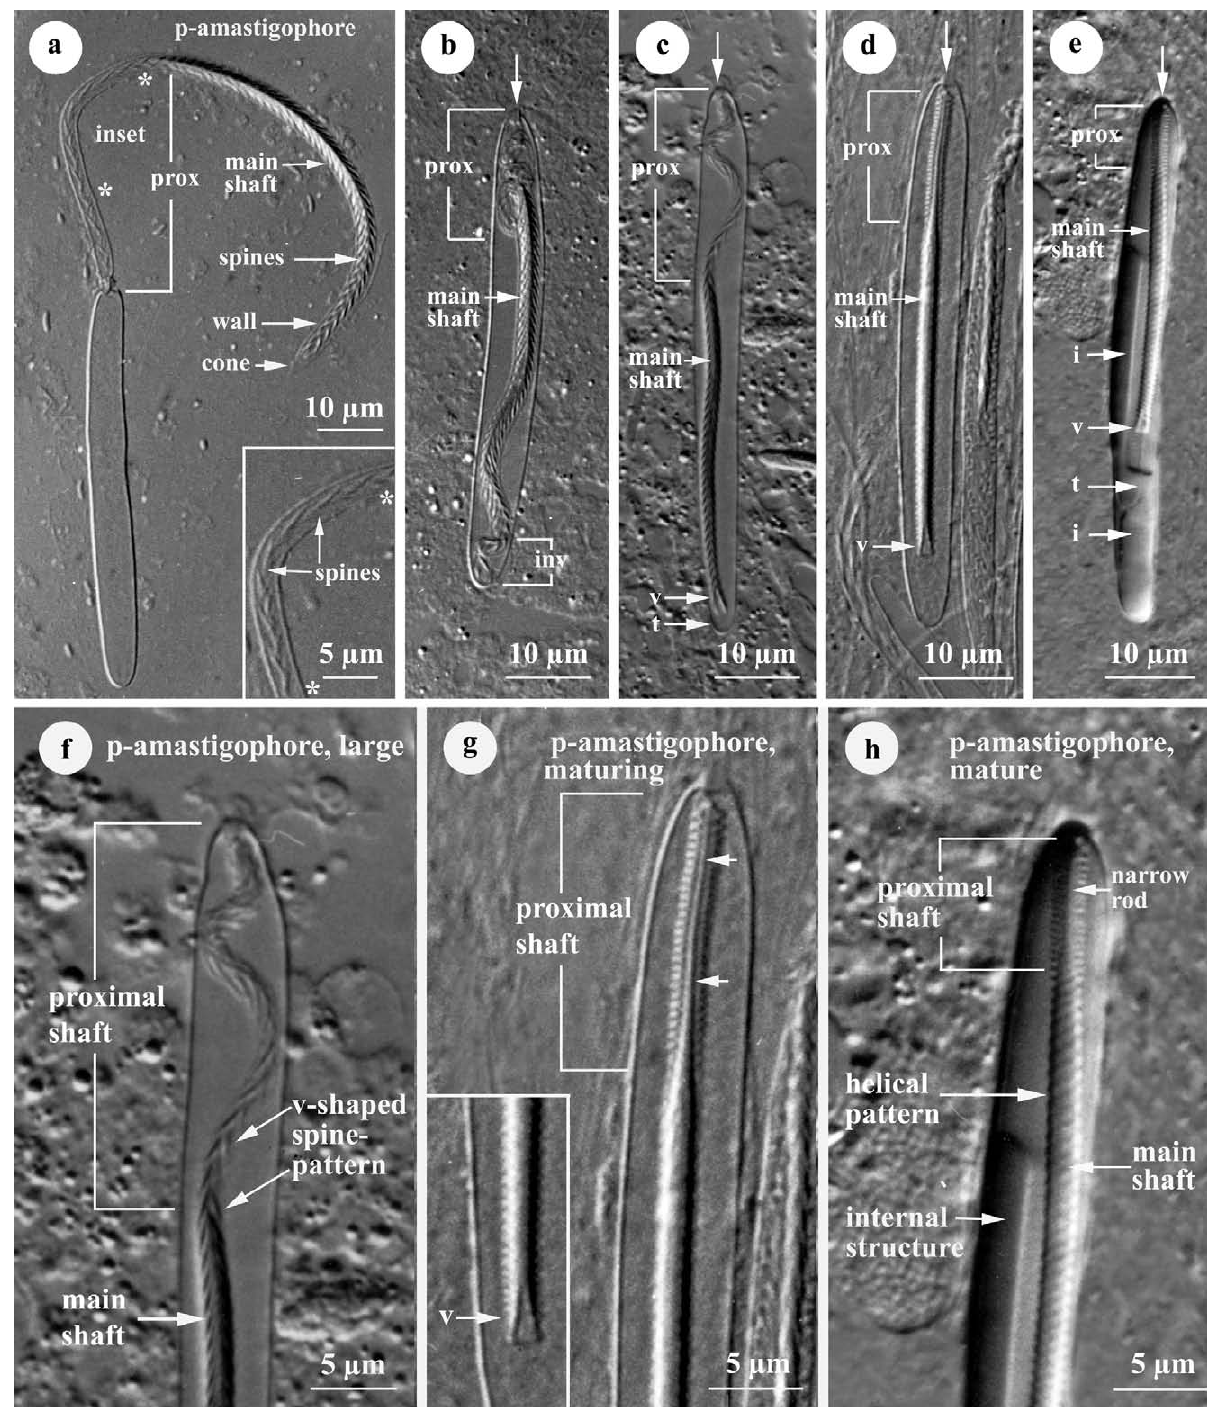
Fig . 6. – Acontia p-amastigophores, large. Inverted shaft differentiated into proximal and main regions. b-e) Illustrate differentiation of the shaft in capsules, interpreted as a time series. a) This empty capsule has ruptured (not seen) releasing the still inverted, elongated shaft. Spines on main shaft particularly clear. Inset) Enlargement of proximal shaft to shows spines (as Fig. 2e). b) Undischarged capsule, immature, with flexed shaft appearing longer than capsule. Proximal shaft strongly flexed, main shaft undulating. Spines on main shaft form clear V-pattern. Distal shaft flexed (marked inv) will later form the V-shaped notch. c,f) Immature capsule; shaft straightening, shorter, regions clear; V-pattern of spines still visible; distinct V-notch at shaft end. d,g) Immature capsule; shaft straight, slightly shorter. Note proximal shaft with dense helices or corrugations and thin rod along centre of proximal shaft (small arrows). Spines no longer visible. Dense helices around V-notch (g inset). e,h) A mature capsule; shaft fully shortened and rod-shaped. Boundary between regions of shaft indistinct; proximal shaft with tight helices or corrugations, narrow structure faintly visible. Main shaft with spaced helices. V-notch distinct. Arrows point at apical capsule end; small arrows point at thin rod; i , internal structure; prox, proximal shaft; t , tubule; v, V-shaped notch; * indicates area of